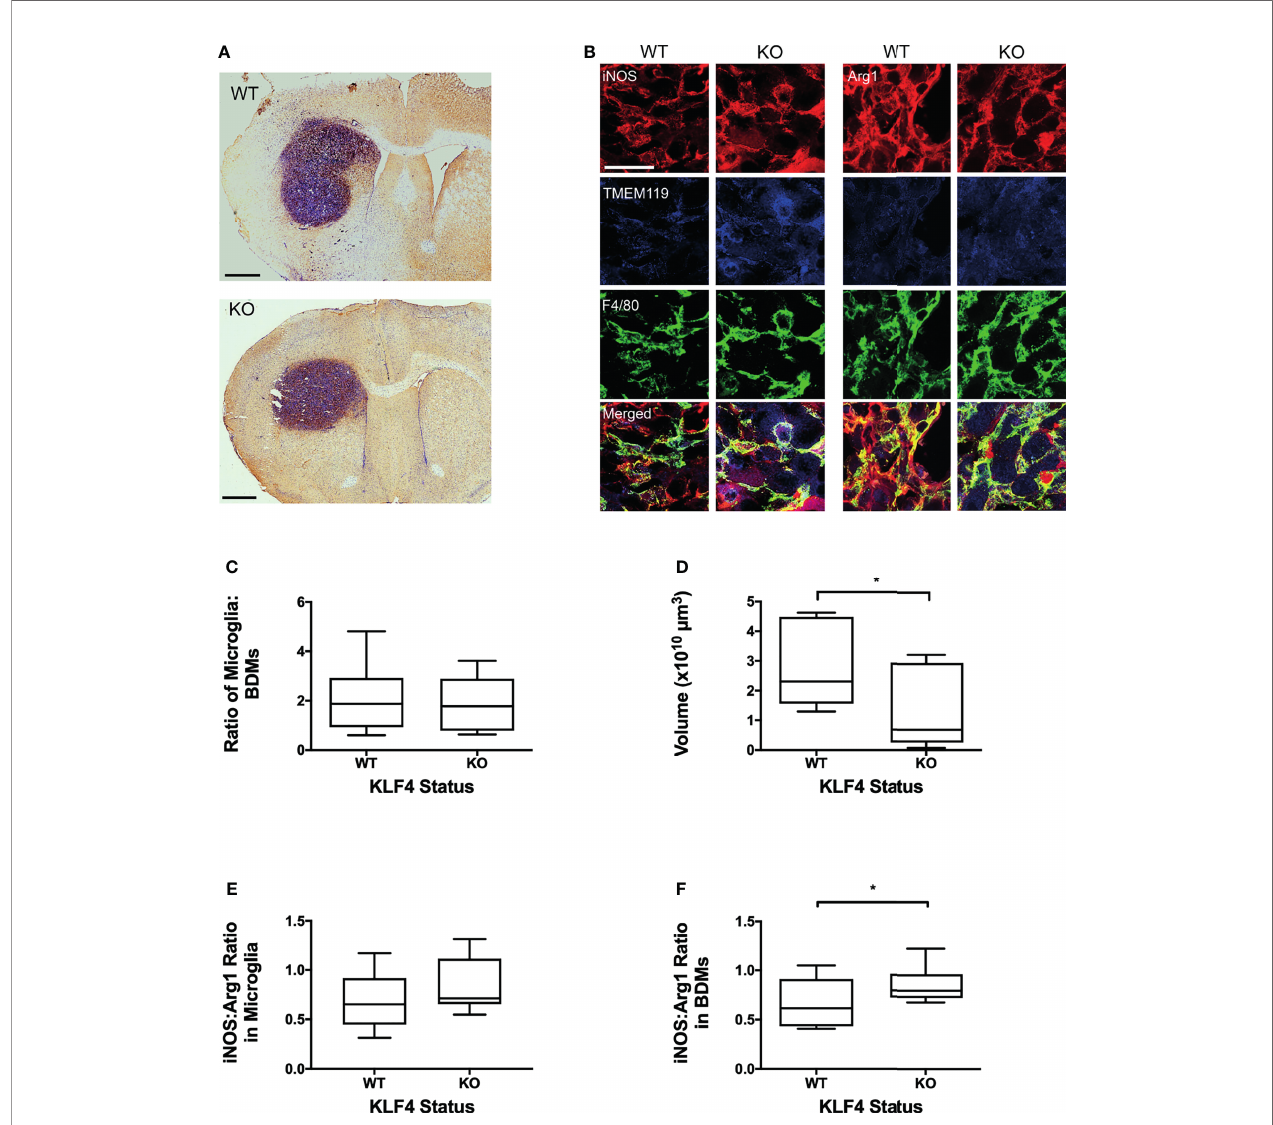
FIGURE 3 | Effect of KLF4 knock out in myeloid cells on phenotype of blood-derived macrophages (BDM) and microglia in brain metastases and tumour growth. (A) Representative IHC images showing F4/80 staining in metastases for wild-type (upper panel, n = 9) and knock-out (lower panel, n = 8) mice. Sections counterstained with cresyl violet. Scale bars = 1 mm. (B) Immuno fl uorescent staining of F/480 (total macrophage/microglia; green), TMEM119 (microglia; blue) with either iNOS (left panels, red) or Arg1 (right panels, red) in WT and KLF4-KO mice. Scale bar = 50 µm. (C) Graph showing ratio of microglia (TMEM119+ F4/80+) to BDM (TMEM- F4/ 80+) in WT and KLF4-KO mice. (D) Graph showing tumour volumes in WT and KLF4-KO mice. (E, F) Graphs showing ratios of iNOS : Arg1 expression, in WT and KLF4-KO mice, in (E) microglia (p = 0.152) and (F) BDM (p = 0.036). Data shown as box and whisker plots depicting full range of data pointspoints. *p <